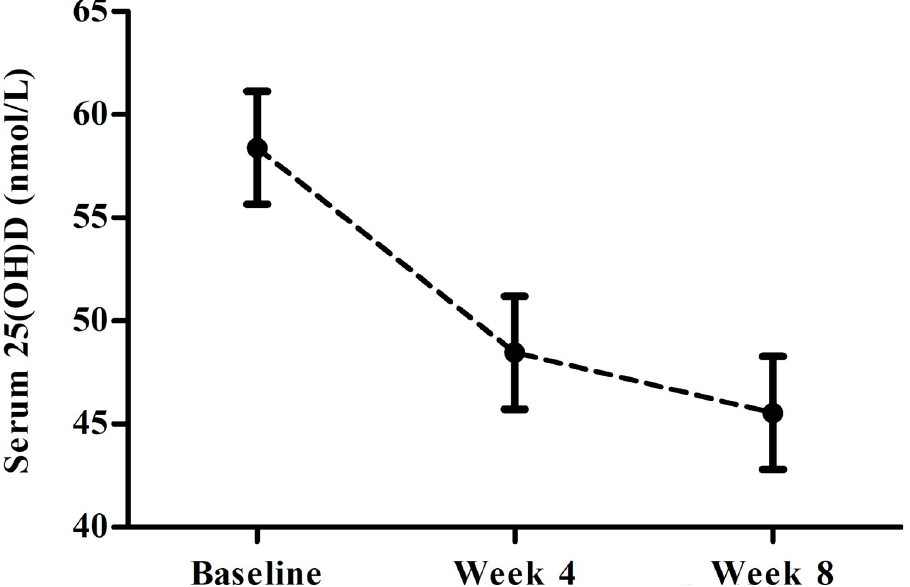
Fig 3. Average serum 25(OH)D over time (Baseline to Week 8) across all participants, error bars represent SE ’s. The study period was from January (Baseline) to March (Week